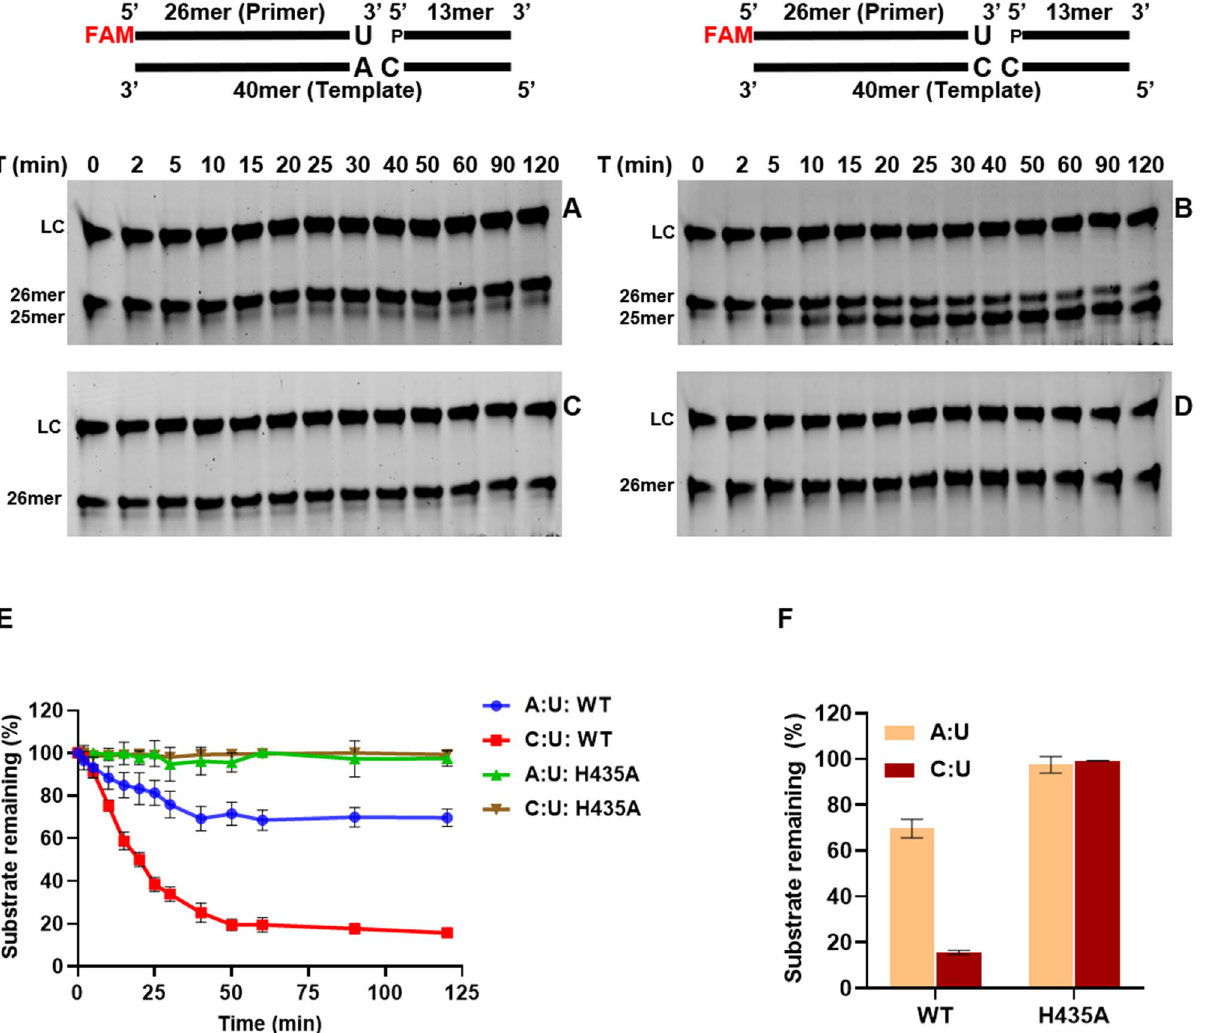
excision by wt-saPolX and H435A for 120 min incubation is